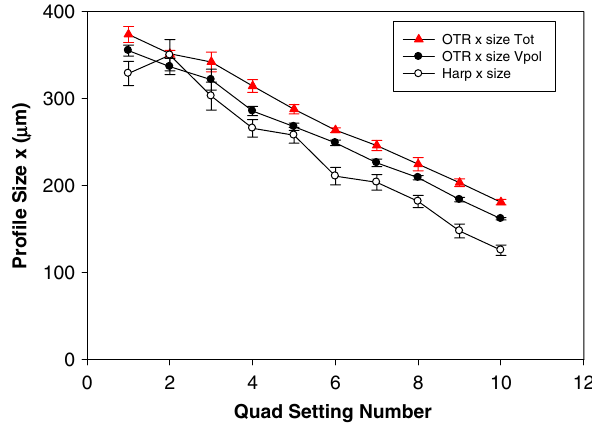
FIG. 10. Comparison of the total OTR projected profiles in x , vertically polarized (Vpol) OTR results, and the wire harp results as a function of upstream quadrupole (Quad) settings at 4.5 GeV [16].